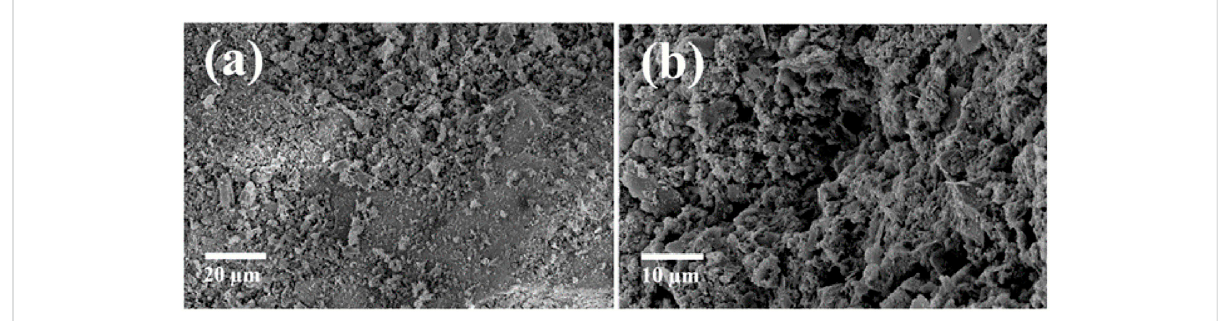
FIGURE 5 SEM image of some uranium tailings samples: (A) Uranium is present there; (B) Uranium is not present there.